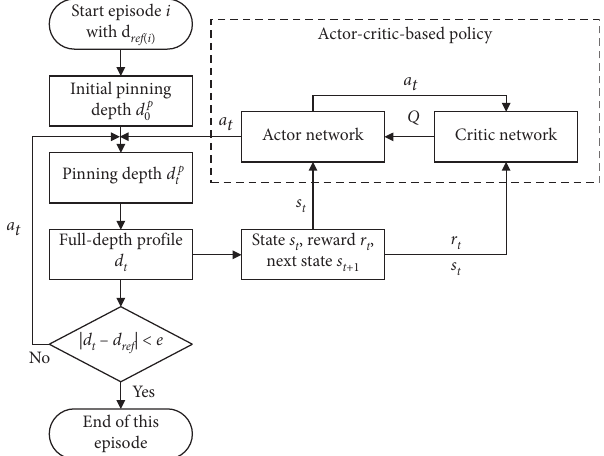
Figure 6: Flowchart of PACS learning process within one